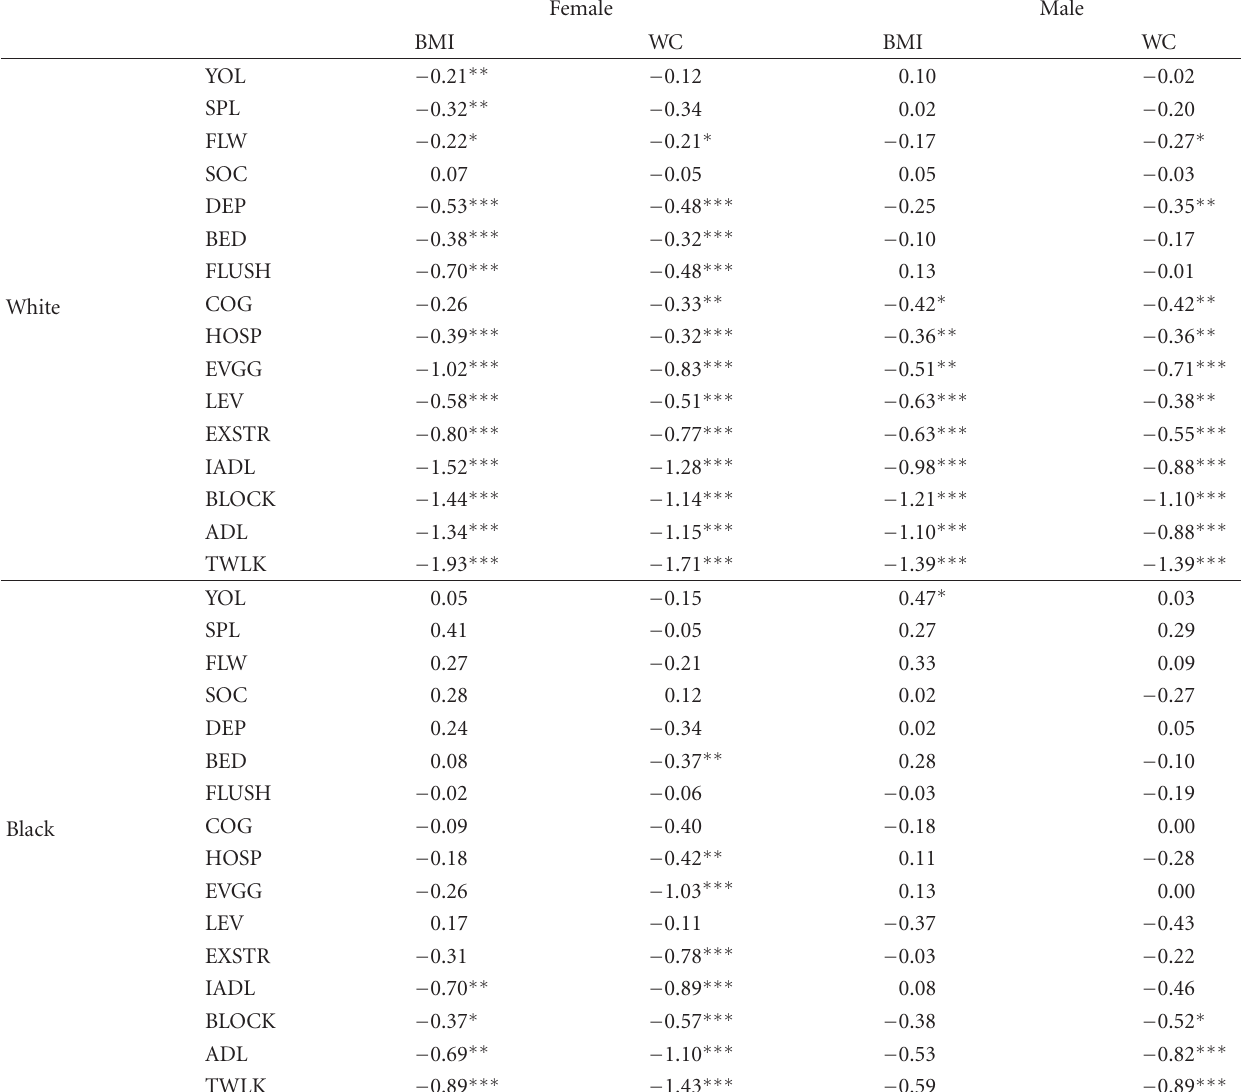
Table 7: Adjusted di ff erence between Obese and Normal YHL (in years; negative values favor